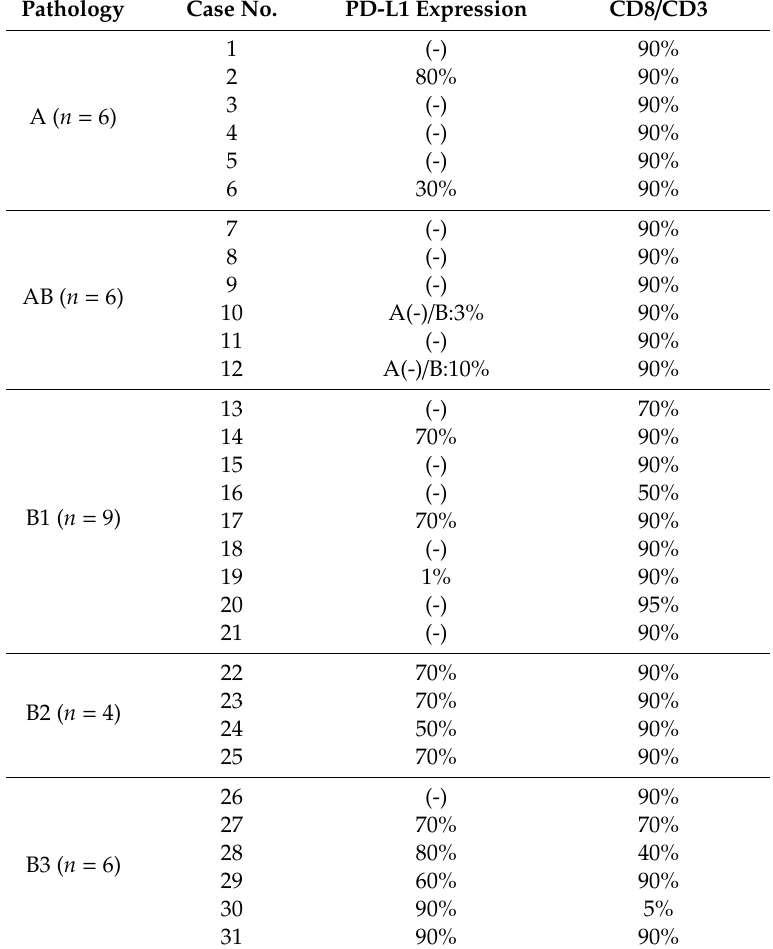
Table 1. Immunohistochemical findings for PD-L1 and CD8 / CD3 in each patient. Pathology Case No. PD-L1 Expression CD8 /